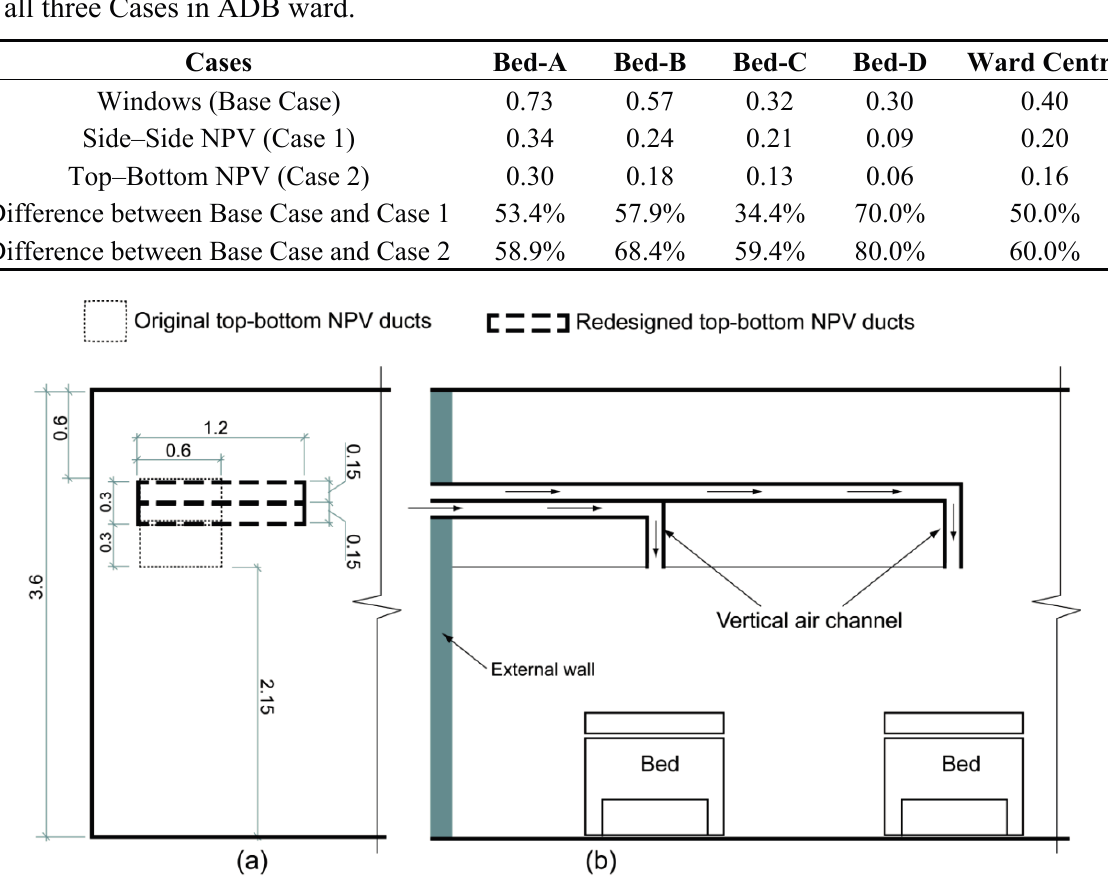
Figure 7. Re-design of the Top–Bottom NPV duct to create vertical air discharge channels, shown as: ( a ) External facade view; and ( b ) Cross-sectional